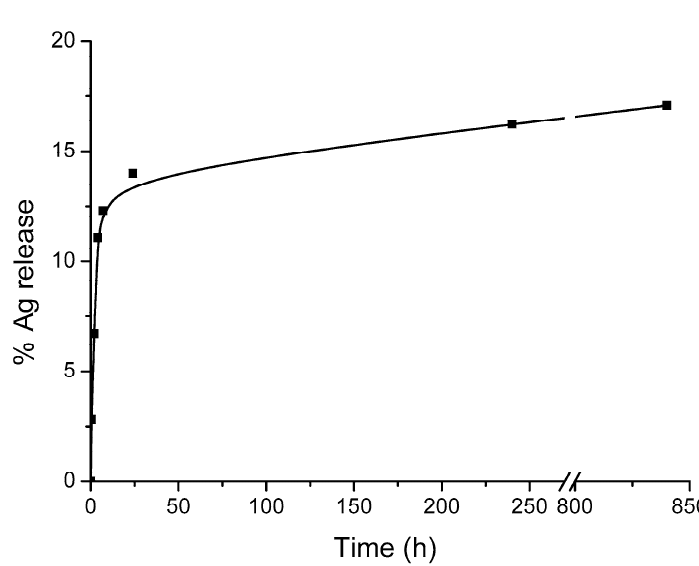
Figure 4. Silver release curve of Ag@ZG-0.125 in MEM cell culture media at 37 °C.